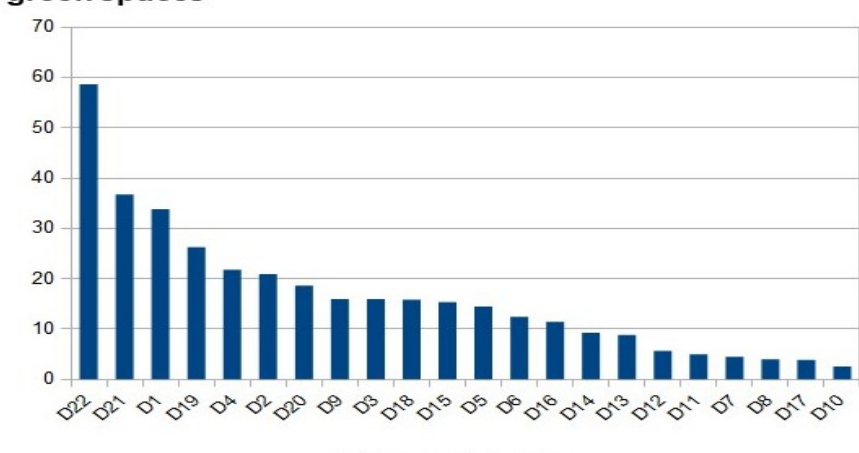
Figure 3. Distribution of per capita green spaces across Tehran districts.